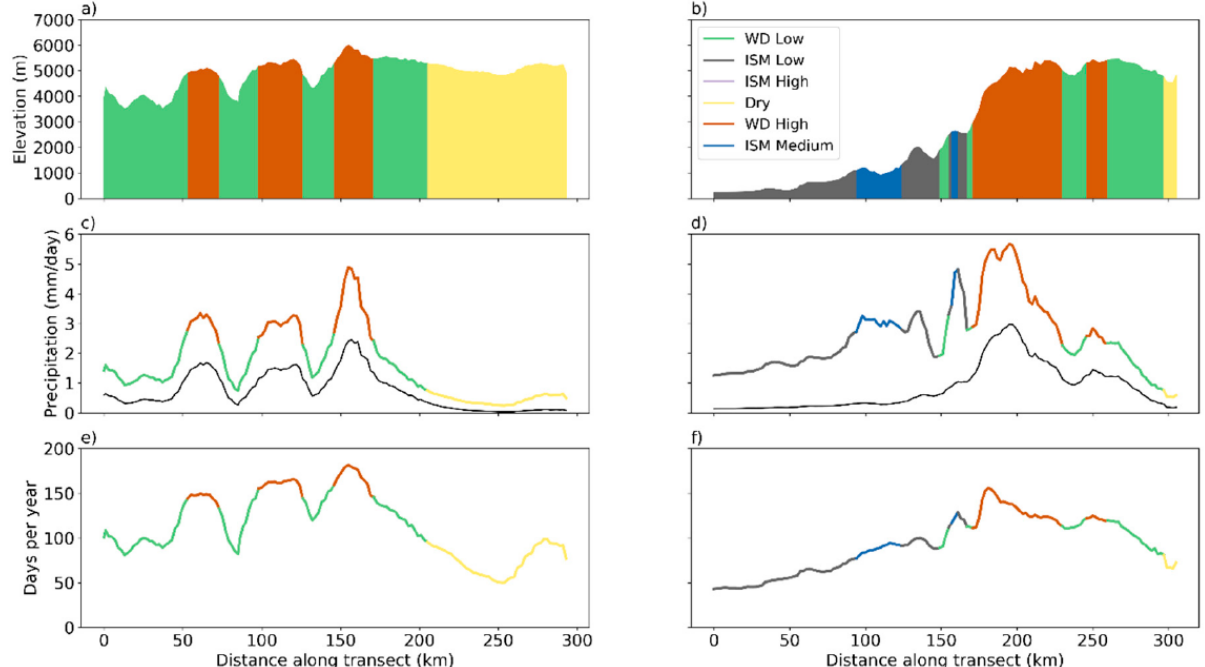
Figure 4. Transects through the Karakoram (left) and western Himalaya (right), showing elevation ( a , b ), precipitation (with cool season (December–March) precipitation in black) ( c , d ), and precipitation frequency ( e , f ). Lines are colored according to the mode of the K-means cluster along the transect, with the same color scheme as Figure 2. Both transects run from southwest to northeast and are shown in Figure